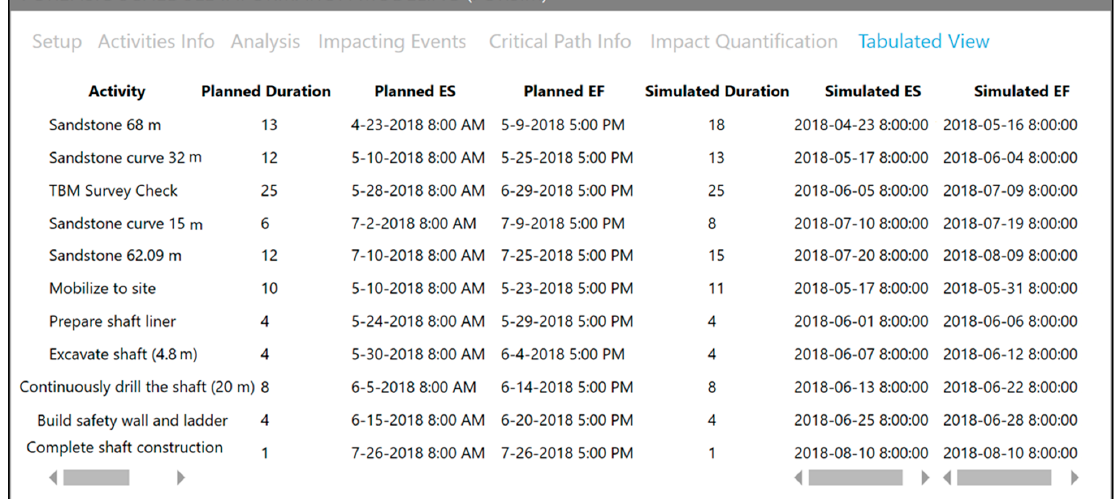
Figure 9. Tabulated view of simulated activities information.